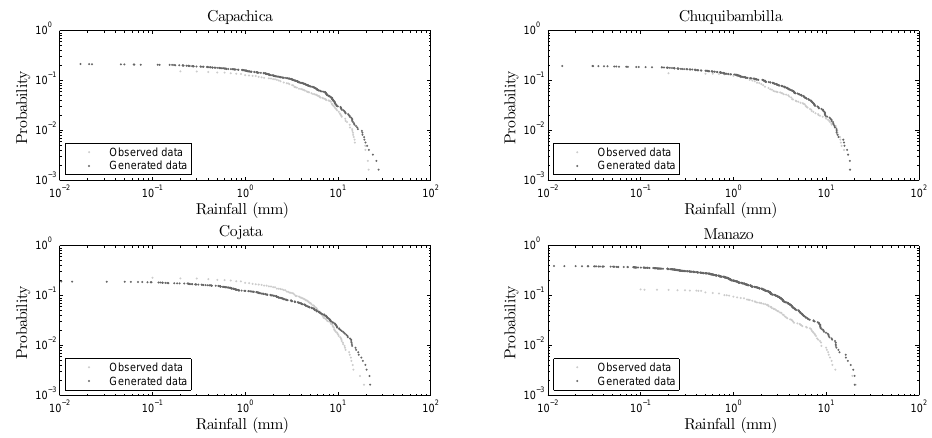
Figure 21. Exceedance probability plots for the non-rainy season (June–October) over an 8-year period of observed and simulated TRMM measurements for stations Capachica, Chuquibambilla, Cojata and Mañazo.